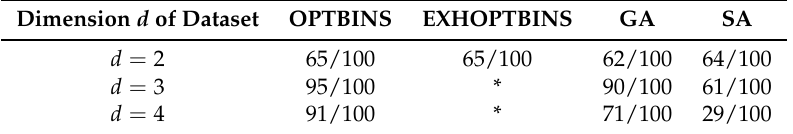
Table 1. Number of datasets with true binning v selected for each dimension of the dataset d . Dimension d of Dataset